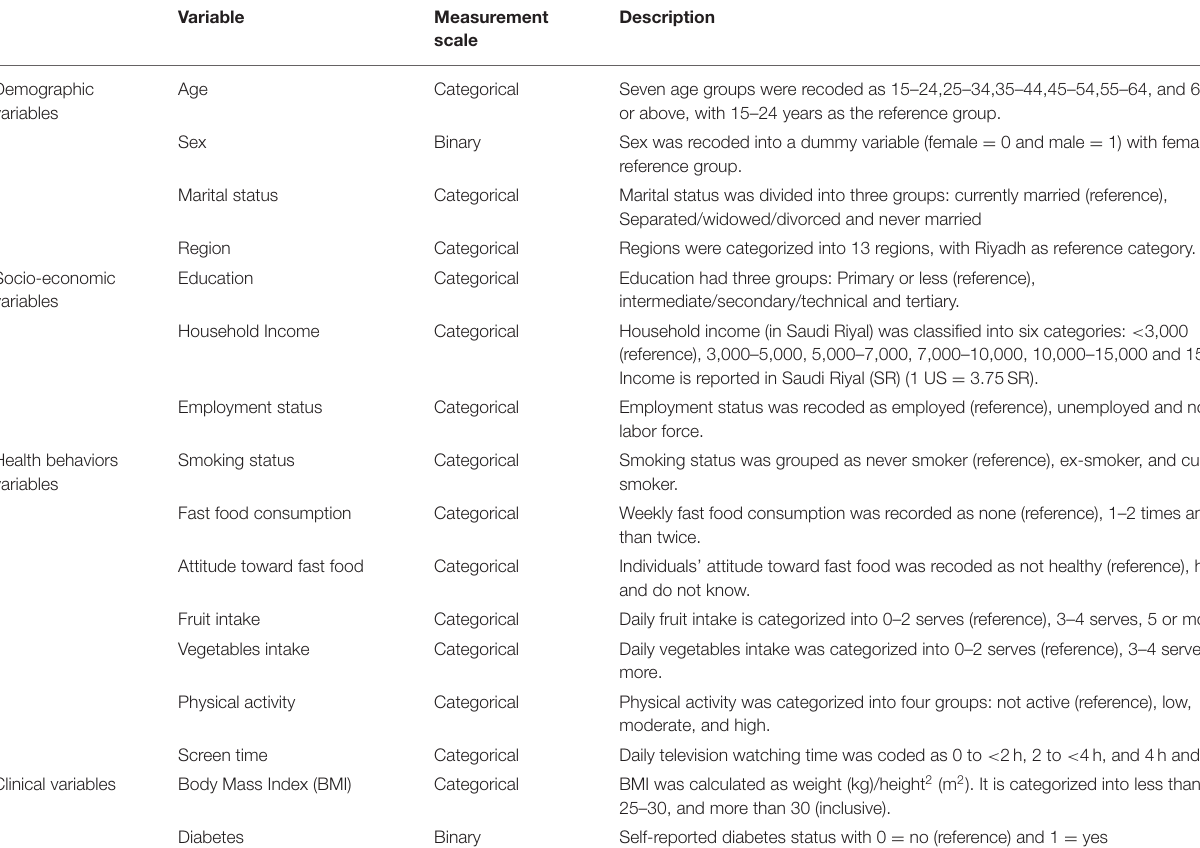
TABLE 1 | Description of independent